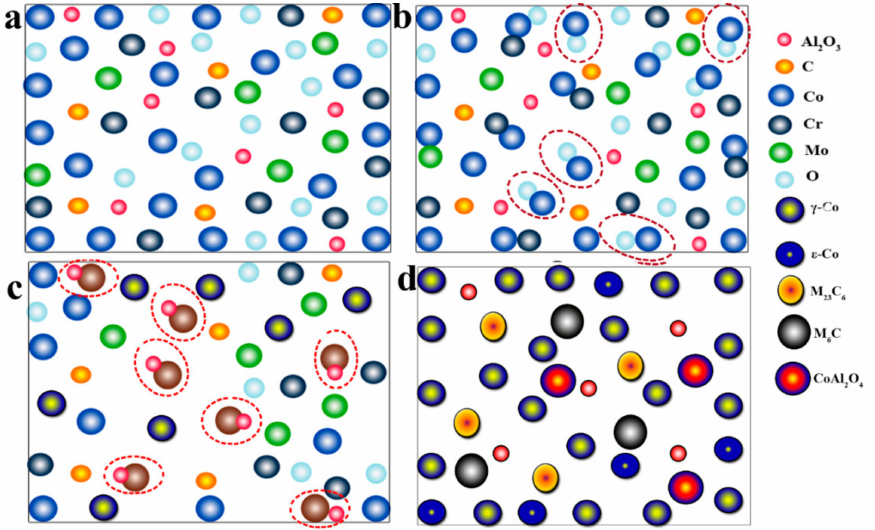
Figure 16. Compound formation process. ( a ) The initial state of melting of the alloy; ( b ) the process of reacting to form CoO; ( c ) the process of forming CoAl 2 O 4 ; ( d ) the final state of the